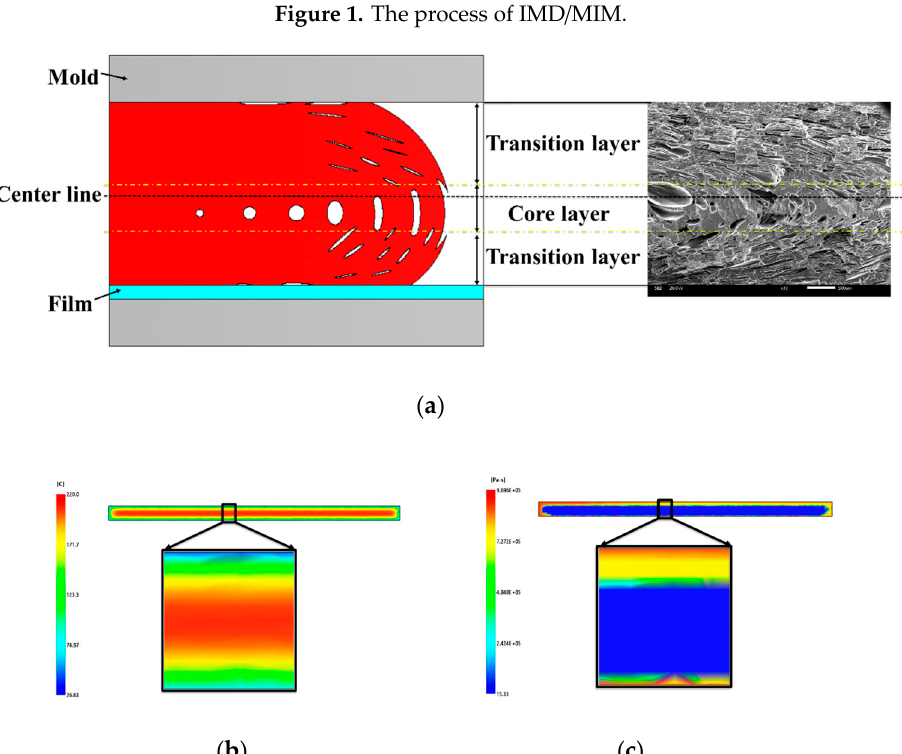
Figure 2. ( a ) Melt flow and cell deformation of IMD / MIM process; ( b ) temperature of parts; ( c ) viscosity of parts.